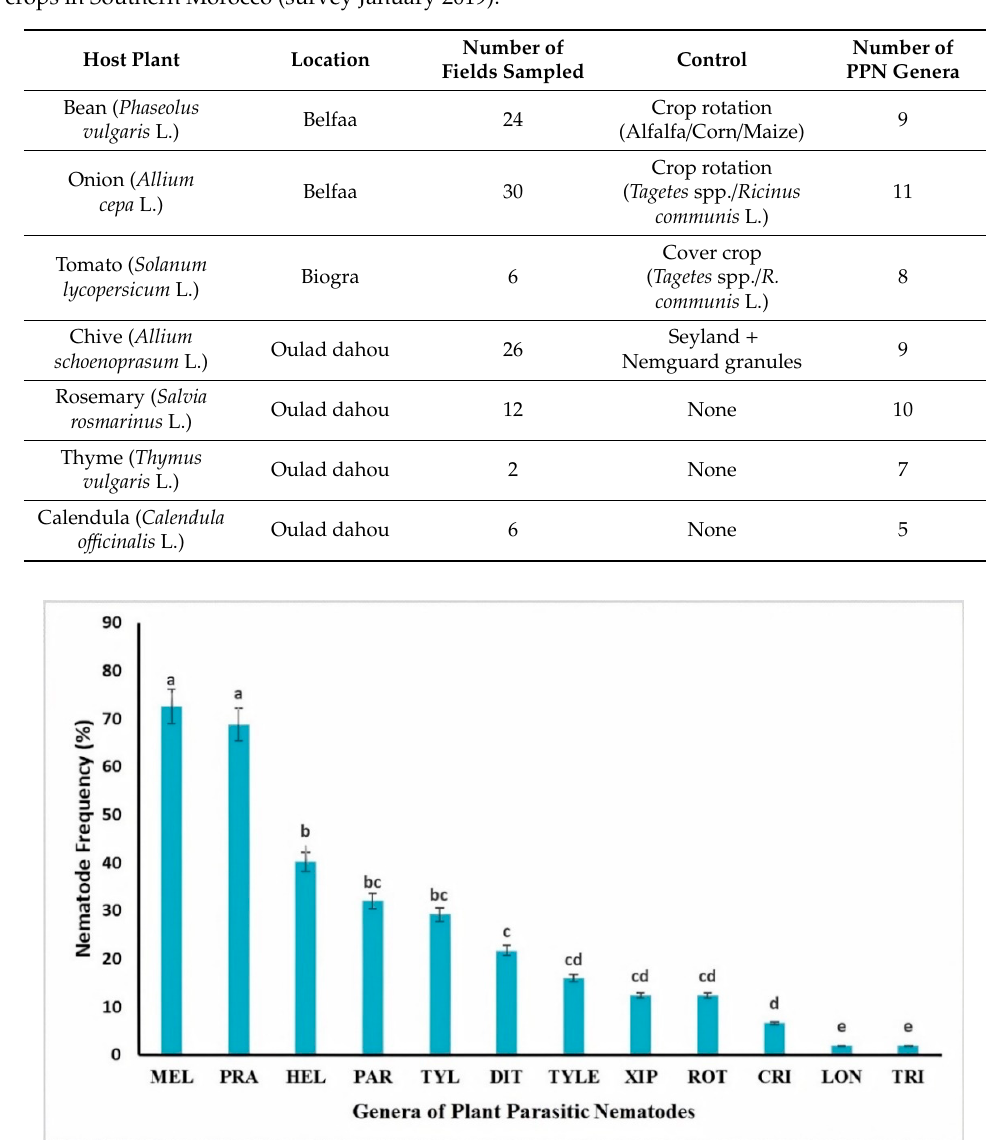
Figure 1. Total frequencies of plant parasitic nematodes obtained in all organic farming systems surveyed. Letters represent homogeneous groups based on protected least significant difference test (LSD) for each variable at ( P < 0.001).